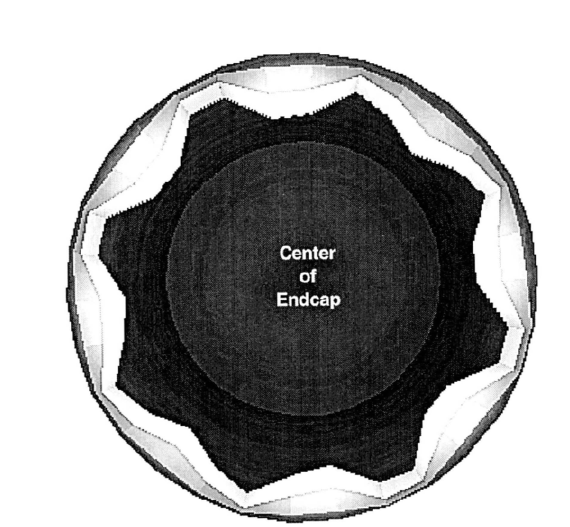
FIGURE 8 Cross-sectional view of projectile 0.80 ms after impact revealing circumferential buckling mode (scale factor =